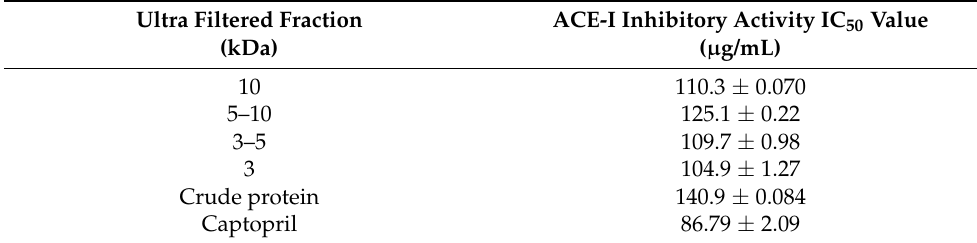
Figure 1. ACE-I inhibitory activity of chickpea protein fractions. * and ** significantly different from each other ( p < 0.05) and ns (not significant). Table 1. ACE-I inhibitory activity with IC 50 of chickpea protein